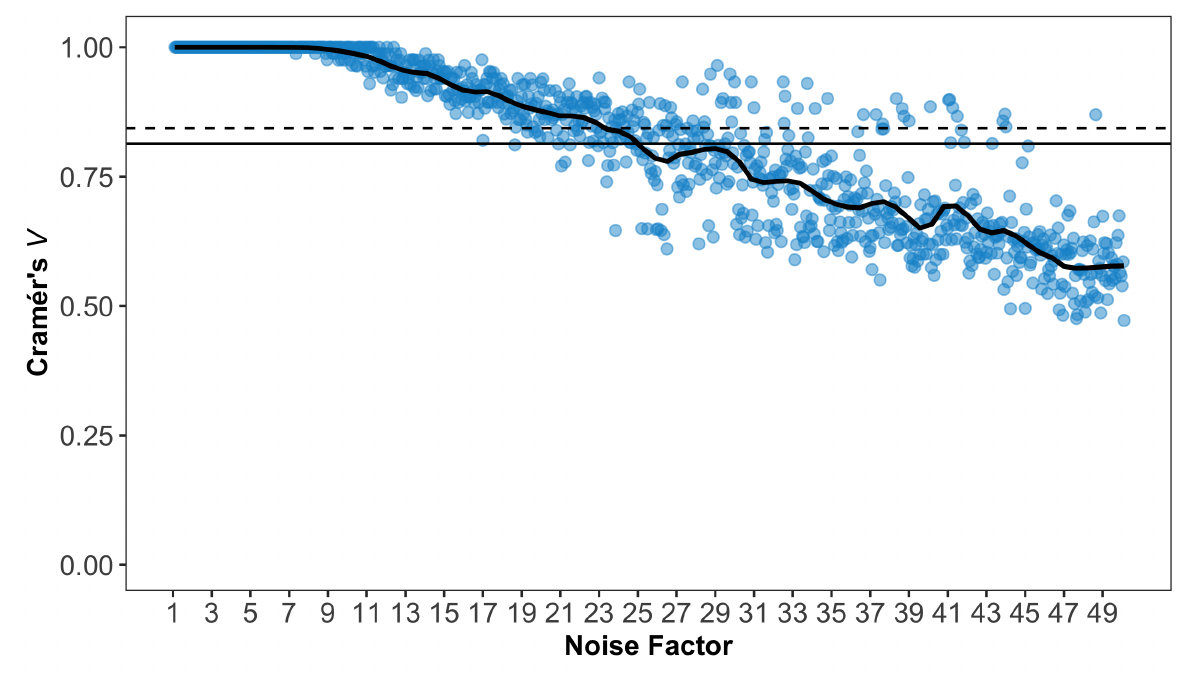
Figure 4: Accuracy. Note : The solid line is the mean Cramér’s V ; the dashed line is the median. deviation of 0.15; the median was 0.84. The interquartile range was 0.29, with a